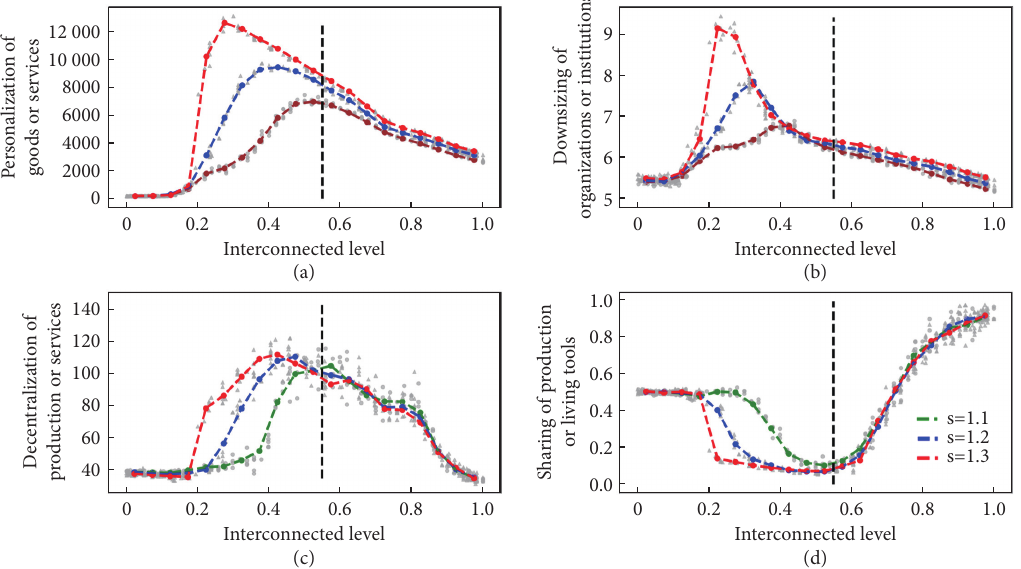
Fig. 2 Evolution trend of the “Four Directions”. The change curve of the personalization of goods or services (a), the downsizing of organizations or institutions (b), the decentralization of production or life (c), and the sharing of production or living tools (d) with the interconnected level. We use the total number of people whose need is met by products of a single enterprise as an indicator of the personalization of goods or services. A large indicator denotes a low degree of personalization. The average number of employees in the enterprise is used as the indicator of the downsizing of organizations or institutions. A large indicator denotes small organizations or institutions. The largest number of people gathered in the geographical distribution is used as the indicator of the decentralization of production or life: a large indicator denotes a low degree of decentralization. The proportion of rental behavior in the exchange of goods or services is used as the indicator of the sharing of production or living tools. A higher indicator denotes a high degree of sharing. The green, blue, and red dotted lines in the figure represent the indicator changes when the specialization economic coefficient s = 1.1, 1.2, and 1.3, respectively. A large specialization economic coefficient indicates a small corresponding interconnected level when the indicator starts to change (a)−(d), and the change is substantial (a)−(c). The black dotted line corresponds to the current measured value of 0.55 for the interconnected level in